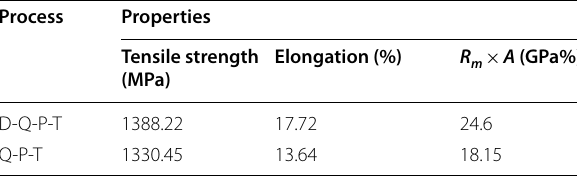
Table 2 Mechanical properties for D-Q-P-T and Q-P-T [31] Process